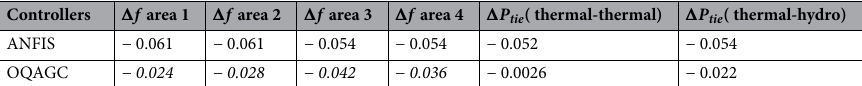
Table 5. Comparative study of under peak overshoot 56 . The designed Optimal Quadratic Automatic Generation Controller with peak overshoot values are in italics.